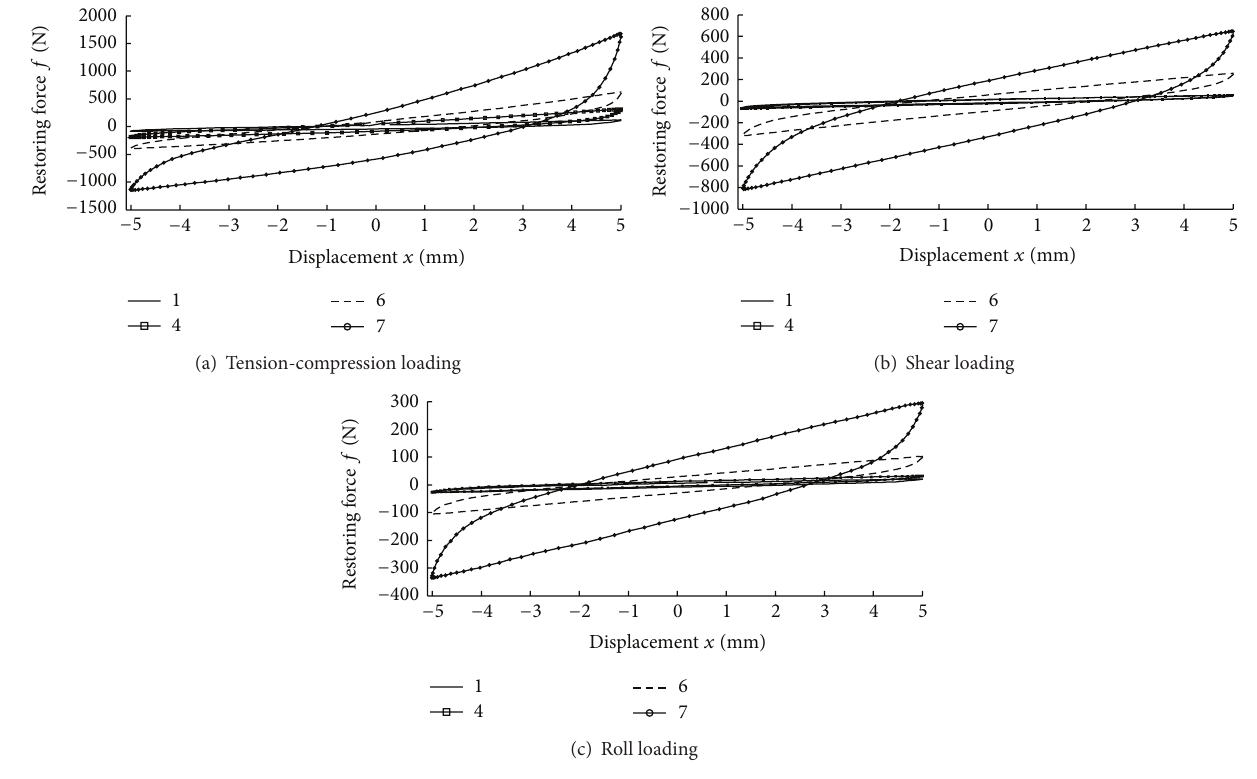
Figure 6: Experimental hysteresis loops of isolators with different wire rope diameters.